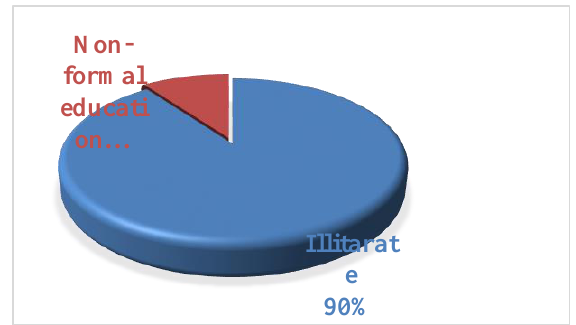
Fig 2: Distribution of injured children by fathers education, n=10 According to fig-2, total 9(90%) fathers of injured children were illiterate and the rest 1(10%) were non-formally educated.